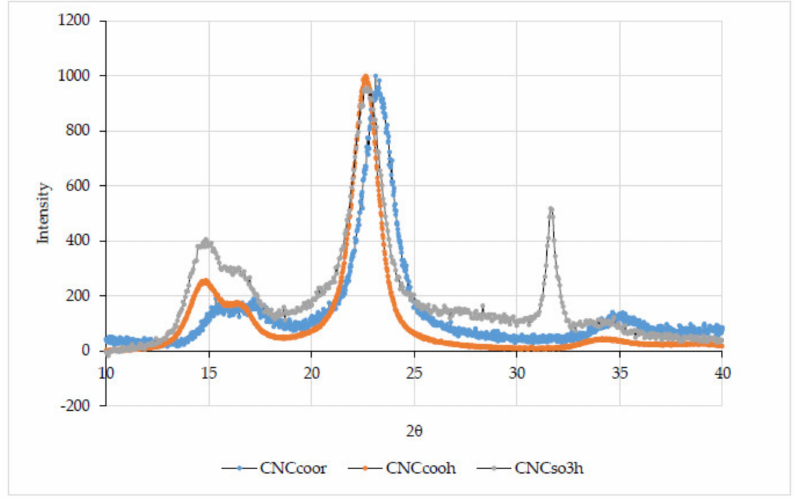
Figure 3. Wide Angle X-ray Scattering (WAXS) di ff ractograms for all three